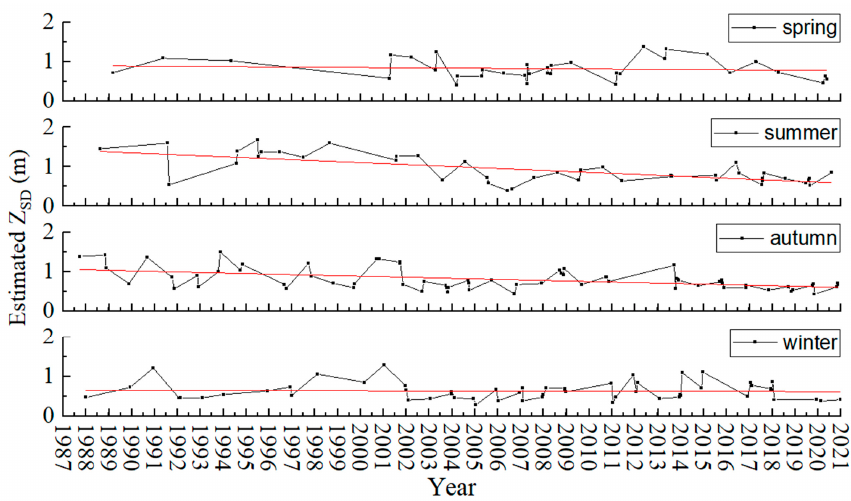
Figure 8. Time series of Landsat-estimated Z SD (mean value of the central lake area) from 1987–2020. There are 205 points in total, with a general downward trend. The Z SD of Honghu Lake showed a distinct seasonal pattern. Figure 9 demonstrates the Z SD variation from 1987–2020 by season; the Z SD in summer had the most evident downward trend, while the other seasons have also declined, but not to a great extent. Figure 10 shows the spatial distribution of the seasonal Z SD in 1991, 2016, and 2020. Over- all, the Z SD was the highest in summer and the lowest in winter.